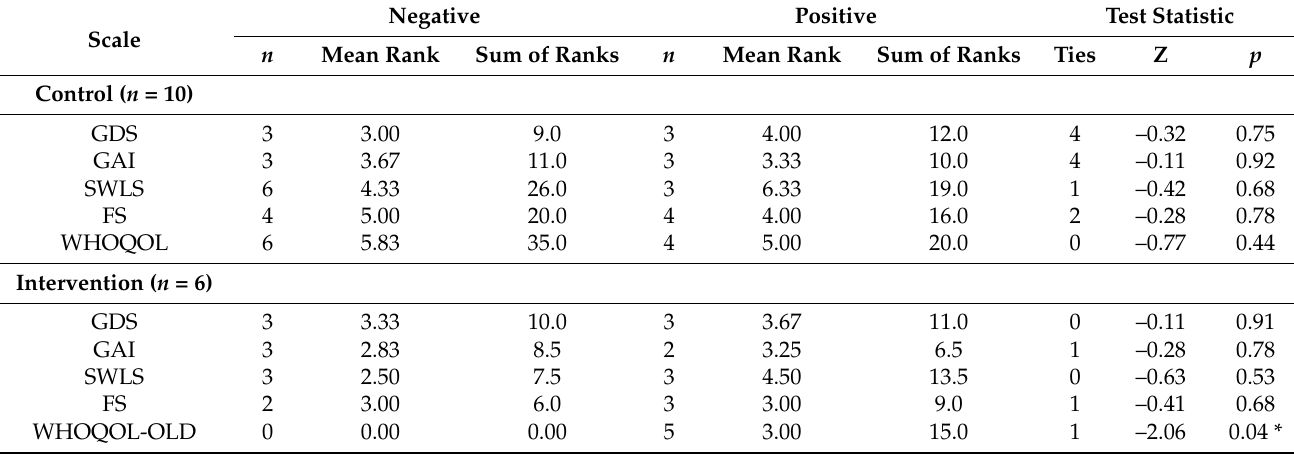
Table 5. Within-group difference for change in outcome scores from baseline to 6